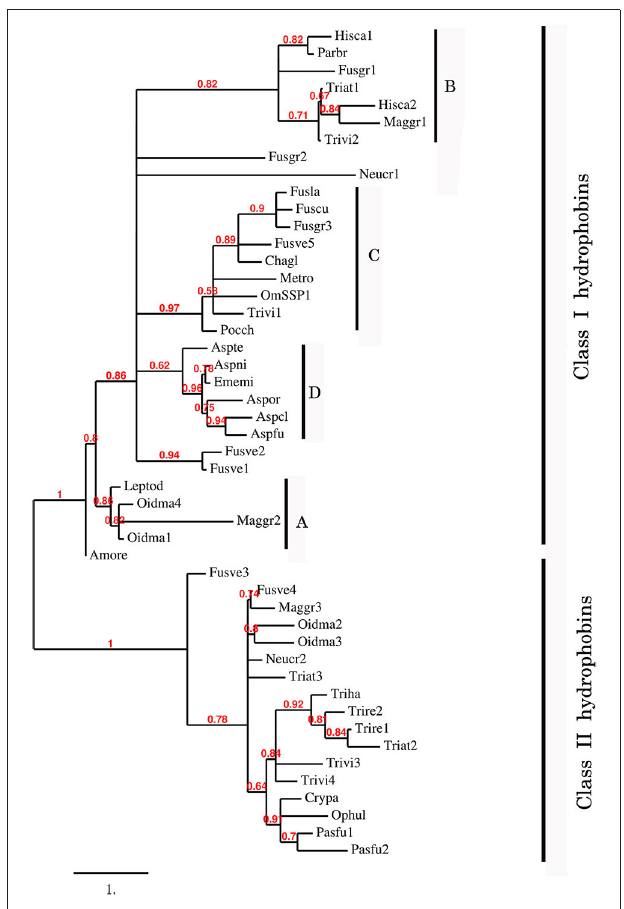
FIGURE 3 | Phylogenetic tree of OmSSP1 and O. maius hydrophobins with other annotated hydrophobins from Ascomycetes. The analysis included protein sequences annotated or described as Ascomycetes class I and class II hydrophobins (listed in Table S3). This sequence alignment considered the complete amino acid sequence comprised between C1 and C8. Muscle algorithm implemented in MEGA7 (Tamura et al., 2007) was used to generate the multiple protein sequence alignment. The phylogenetic tree was reconstructed on the Phylogeny.fr platform (Dereeper et al., 2008) using the maximum likelihood method (Guindon and Gascuel, 2003) implemented in the PhyML program (v3.1/3.0 aLRT). The WAG substitution model was selected assuming an estimated proportion of invariant sites (of 0.088) and 4 gamma-distributed rate categories to account for rate heterogeneity across sites. The gamma shape parameter was estimated directly from the data (gamma = 7.097). Reliability for internal branch was assessed using the aLRT test (SH-Like). Graphical representation and edition of the phylogenetic tree were performed with TreeDyn (v198.3; Chevenet et al., 2006) A–D, terminal clades..